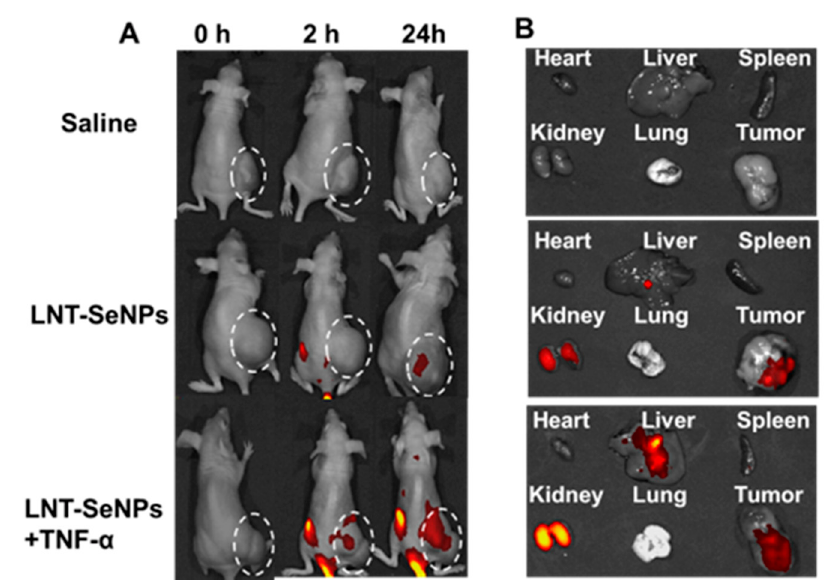
Figure 7. Fluorescence imaging of CT26 tumor-bearing mice receiving different treatments. ( A ) Fluorescence images showing the whole-body distribution of LNT-SeNPs. Tumors were circled by white dashed lines. ( B ) Fluorescence images showing the relative fluorescence intensities among major organs.